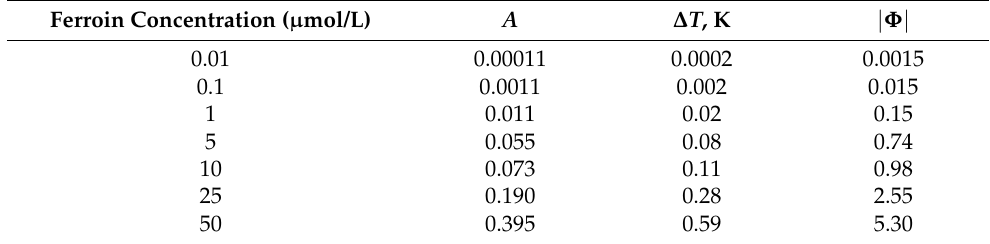
Table 5. Estimation of the phase shift for aqueous solutions of ferroin at a constant power of